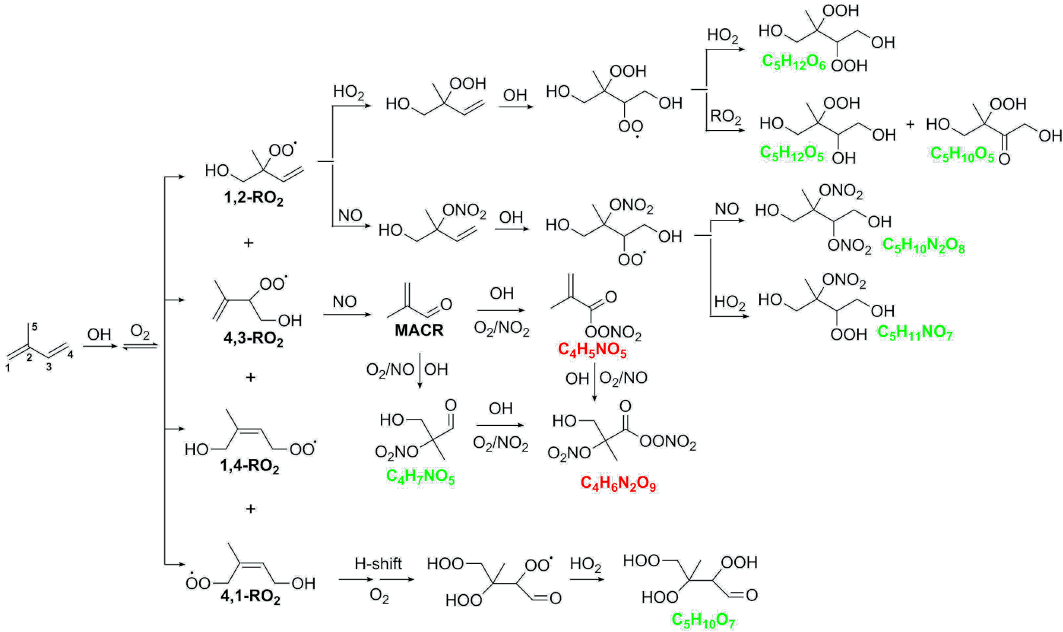
Figure 5. Simplified reaction scheme summarizing known isoprene + OH reaction pathways yielding multigeneration oxidation products. Four peroxy radical (RO 2 ) isomers are generated following initial OH addition to isoprene: 1,2-RO 2 , 4,3-RO 2 , 1,4-RO 2 , and 4,1-RO 2 . The 1,2-RO 2 and 4,3-RO 2 isomers follow the same reaction pathways, yielding chemical formulas with green text that were detected with NO − CIMS. The 4,1-RO 2 isomer yields C 5 H 10 O 7 , also detected with NO − the methacrolein (MACR) channel but were not detected with NO −